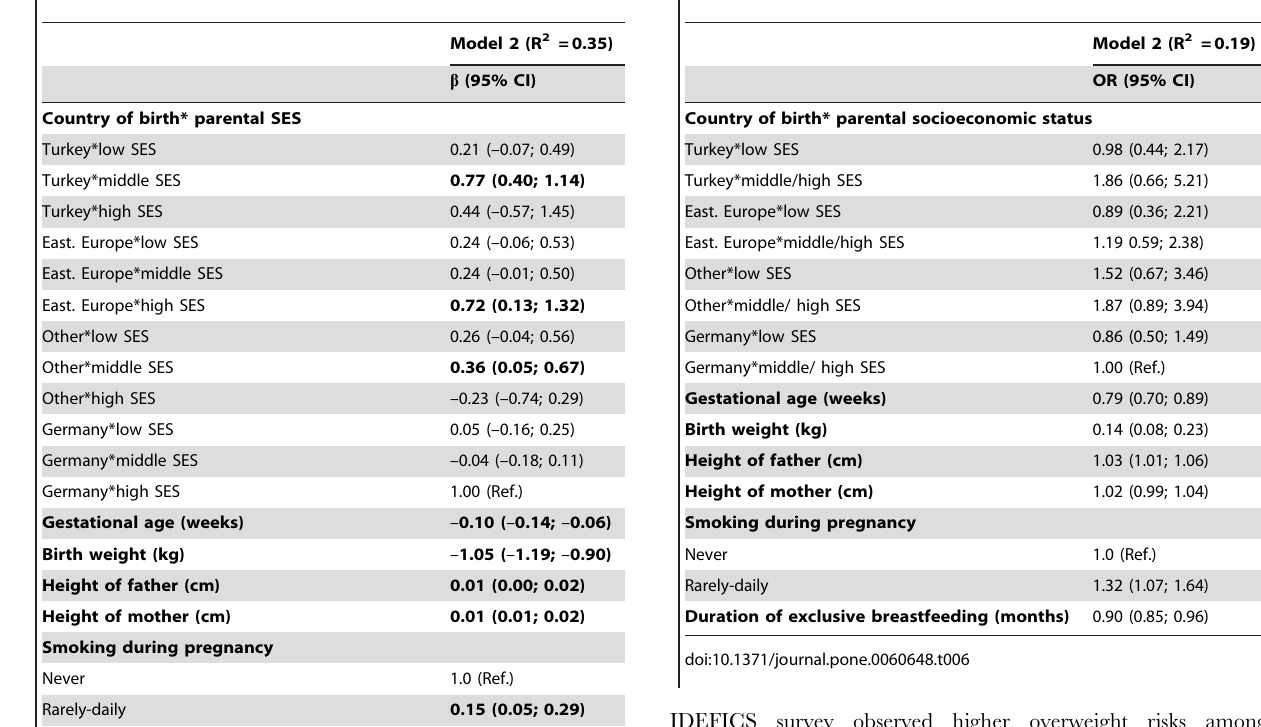
Table 5. Linear regression effect estimates ( b ) for influence of migrant background and parental socioeconomic status on infant weight gain (weight z-score) during first six months of life, adjusted for covariates (n=1,009).